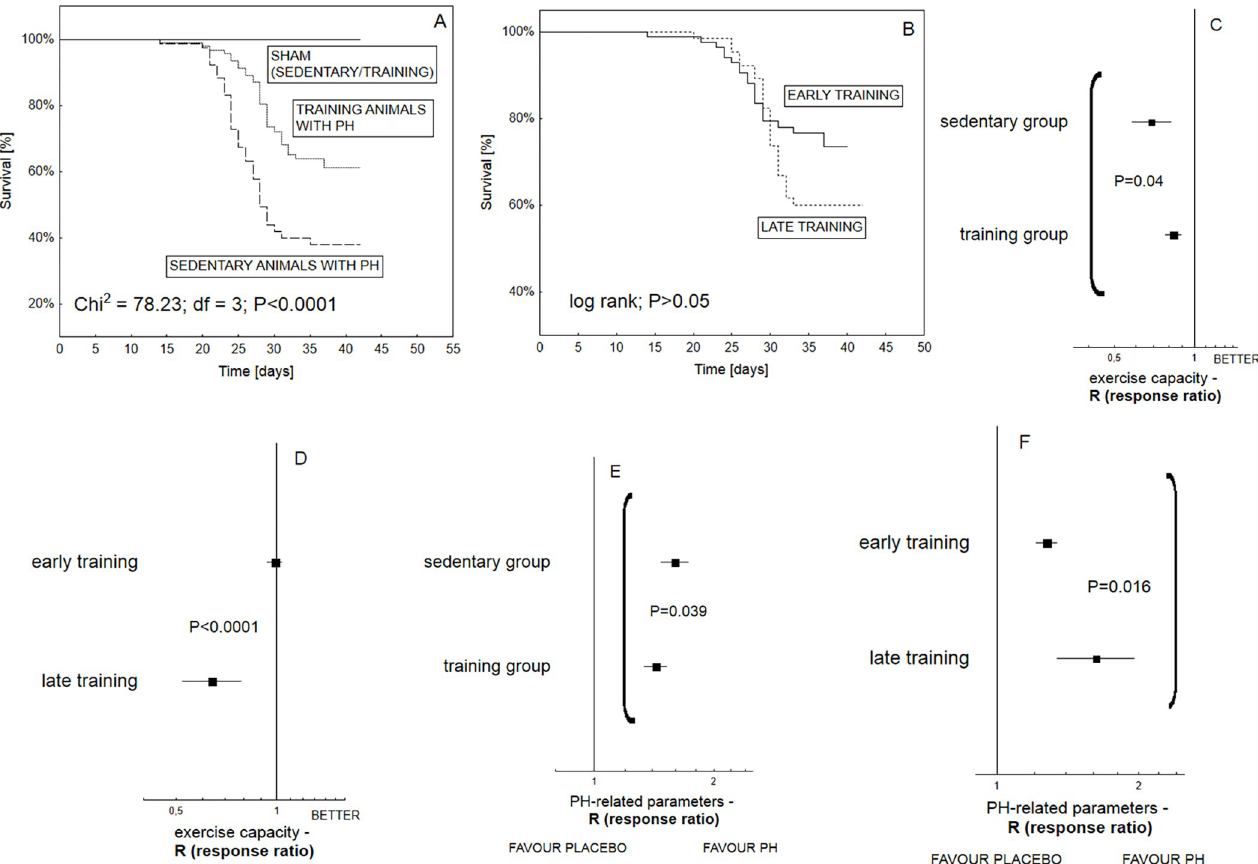
Fig 4. The influence of different exercise training programs on the condition of animals with PH ( n = 1470 animals ). Kaplan-Meier curves demonstrate the significant differences in overall survival among particular study groups (P < 0.0001) that were exposed to different exercise training-related schedules ( n = 266 animals ); the mortality of animals with pulmonary hypertension from sedentary groups was higher than those subjected to exercise training (P = 0.0002) ( A ); early training protocol did not improve survival significantly (P > 0.05) as compared to these subjects with PH that were exposed to the late training program ( B ), animals developed PH due to injection of monocrotaline ( A − B ); tree-plots show that training animals were characterized with significantly better exercise endurance (Q = 4.2; df = 1; P = 0.04) and weaker PH development (Q = 4.3; df = 1; P = 0.039) as compared to their sedentary counterparts ( C , E ); early training programs yielded benefits in relation to exercise endurance (Q = 16.7; df = 1; P < 0.0001) and PH worsening (Q = 5.85; df = 1; P = 0.016) ( D , F ). The overall effect was expressed as response ratio (R), according to alterations in both heamodynamic (RVSP, mPAP) and remodeling parameters (Fulton index, PA muscularization), as well as animal exercise capacity. Increased values of response ratio (R) reveal worsening of PH-related parameters and better exercise endurance ( C – F ). A statistically significant Q measure (P < 0.05) indicates heterogeneity among two or more analyzed